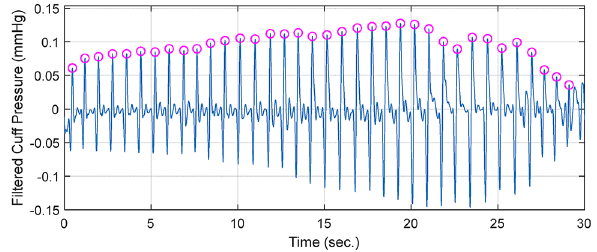
Figure 2. Cuff pressure oscillation for peak